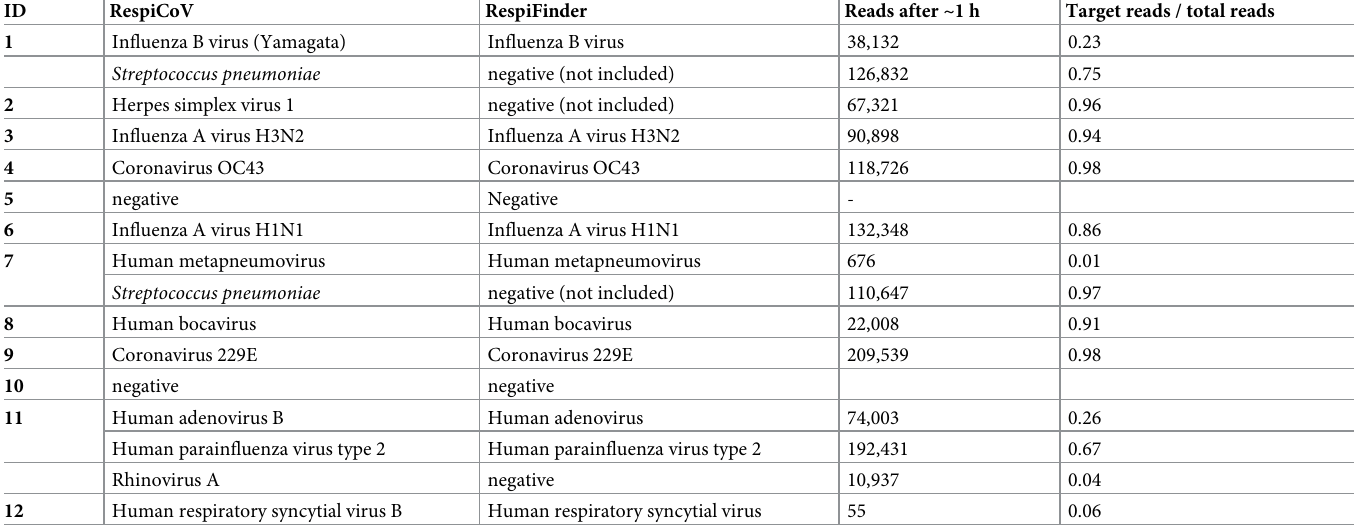
Table 2. Comparison of results for screening of samples from patients with respiratory tract infections with the RespiFinder 2SMART and the RespiCoV Panel. Results for the RespiFinder 2SMART could be confirmed with the RespiCoV Panel. Some additional species could be identified ( Streptococcus pneumoniae , herpes simplex virus 1, and Rhinovirus A).